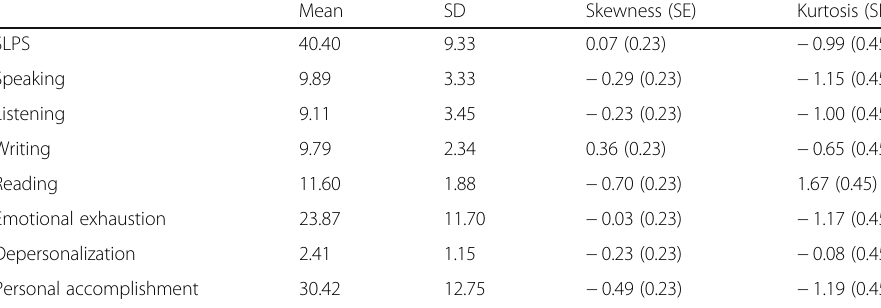
Table 1 Descriptive statistics for SLPS and